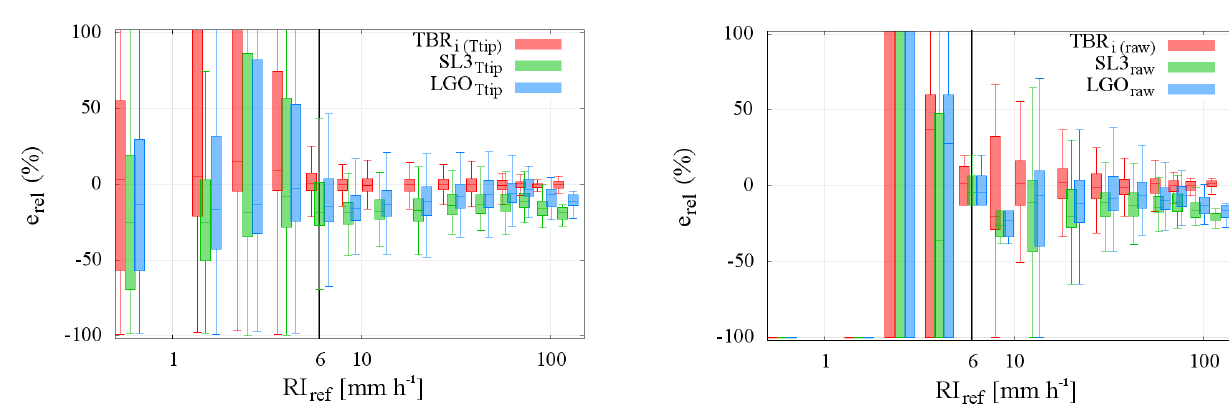
Figure 6. One-minute relative deviations ( e rel ) between the three TBRGs (including the ideal one) and the reference (OSK) when adopting the tip-counting algorithm